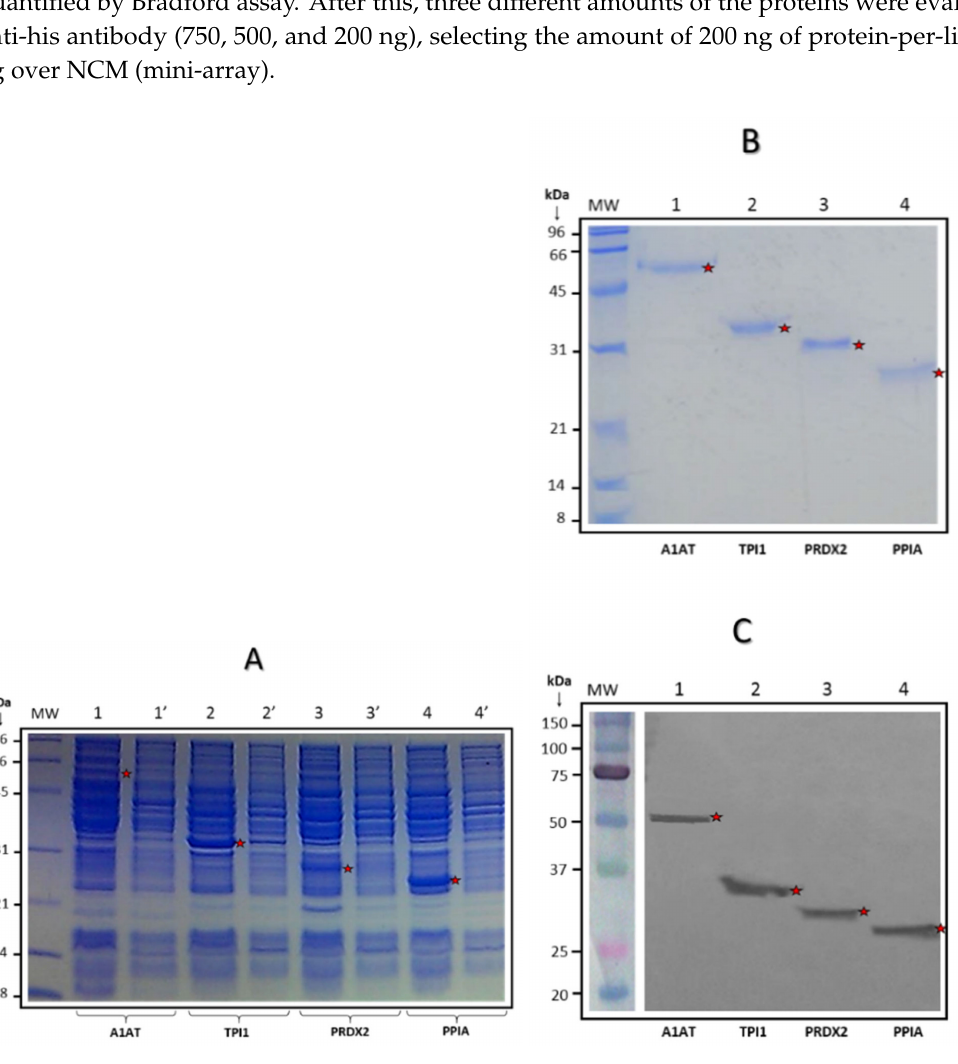
Figure 1. Expression and purification of recombinant Tumor-Associated Antigens TAA. ( A ) Synthesis of four recombinant proteins (TAA) in Escherichia coli . A1AT, TPI1, PRDX2, and PPIA; IPTG positive lanes 1 , 2 , 3 , and 4, respectively, and 1 (cid:48) , 2 (cid:48) , 3 (cid:48) , and 4 (cid:48) IPTG negative lanes. ( B ) Histidine-tagged recombinant proteins were purified using a ffi nity nickel column chromatography; electrophoresed proteins were detected by SDS-PAGE with Coomassie Blue staining. Lane 1, A1AT; Lane 2, TPI1; Lane 3, PRDX2, and Lane 4, PPIA. ( C ) Western-blot assays show the immunoreactivity of four recombinant proteins with anti-histidine antibody. Lane 1, A1AT; Lane 2, TPI1; Lane 3, PRDX2, and Lane 4,